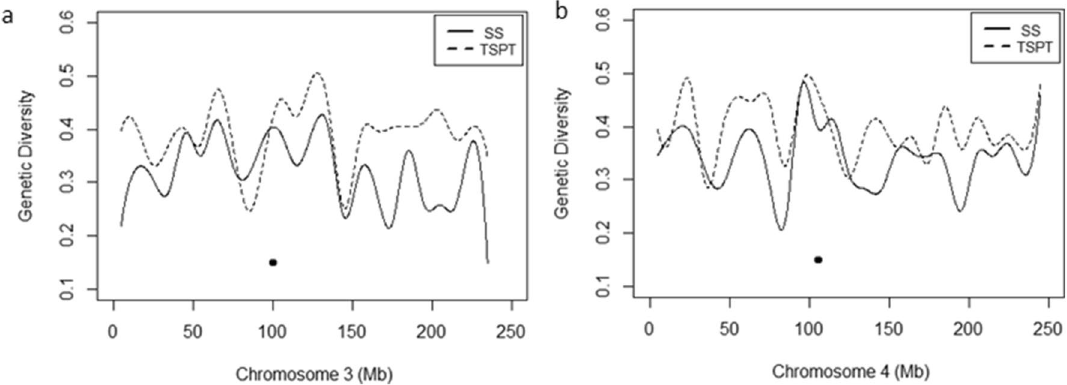
Figure 7. Genetic Diversity (GD) in SS and TSPT across chromosome 3 and chromosome